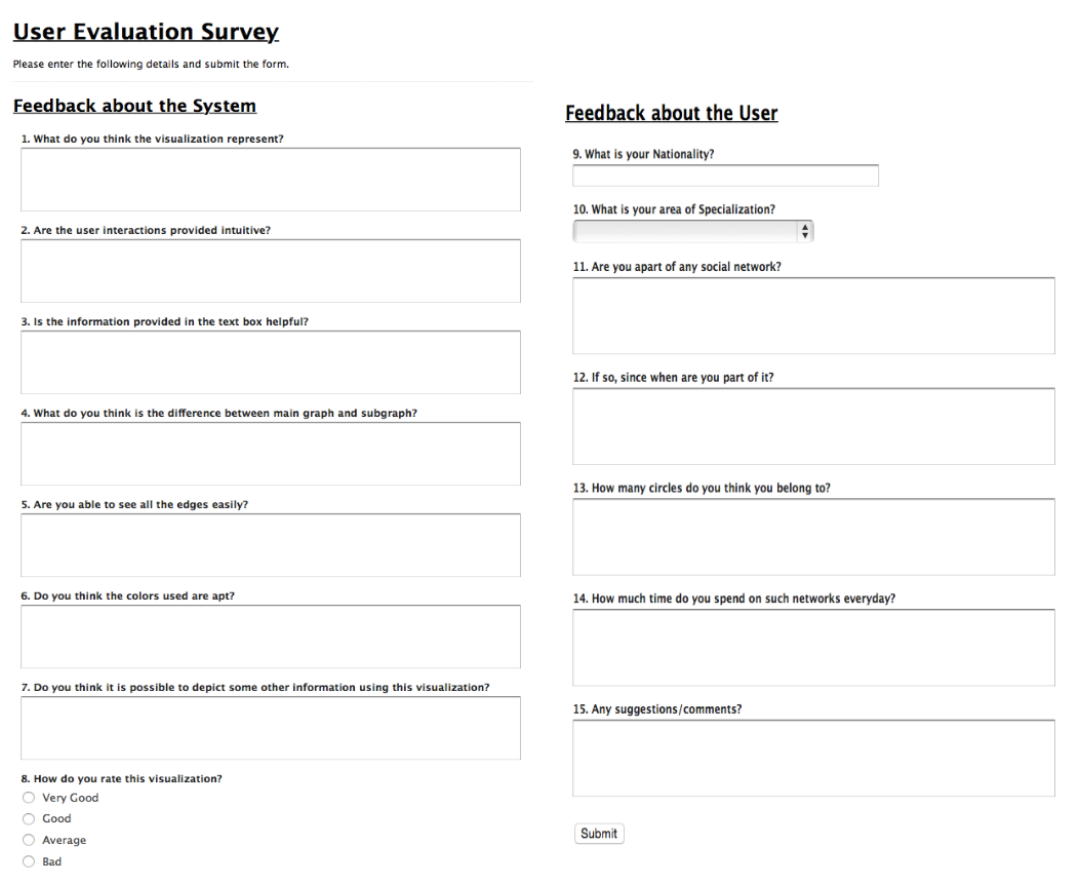
Figure A2. Evaluation form for the user study.